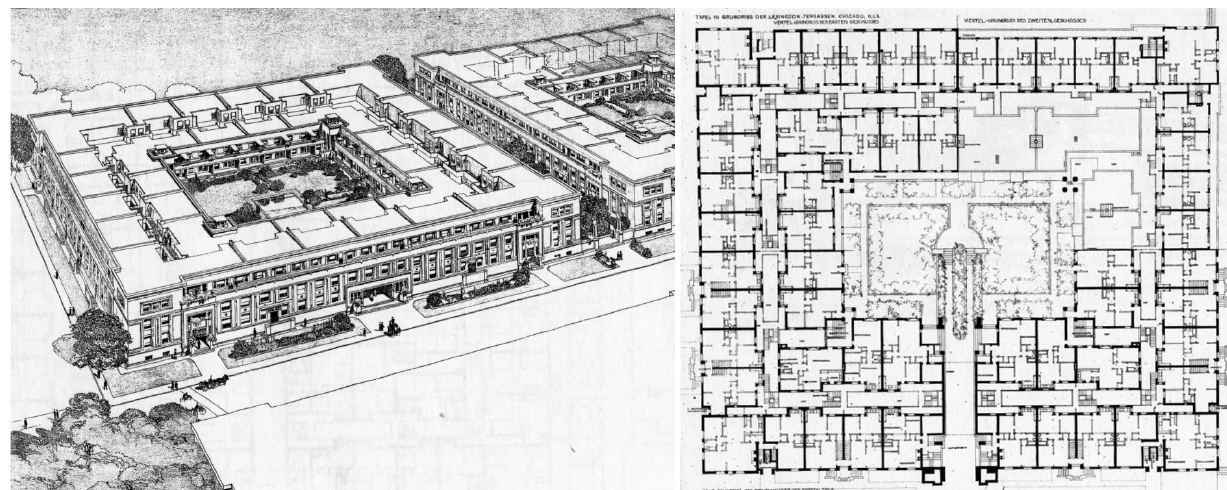
Figure 10. F. L. Wright, Lexington terrace apartments, Chicago, 1894–1901, bird’s eye view and ground plan. Source: Wright (1909).